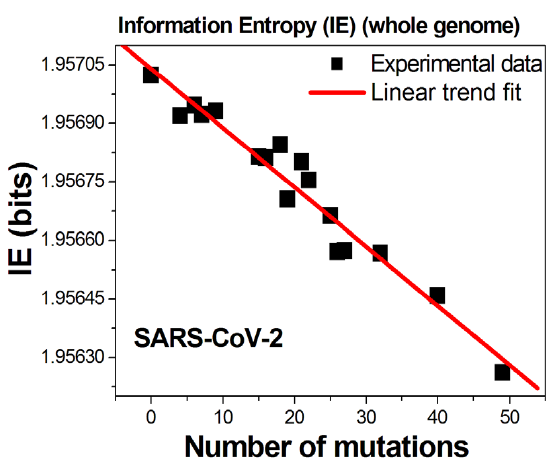
Figure 1. Information entropy values of variants of the SARS-CoV-2 virus as a function of the SNP mutations detected per variant.